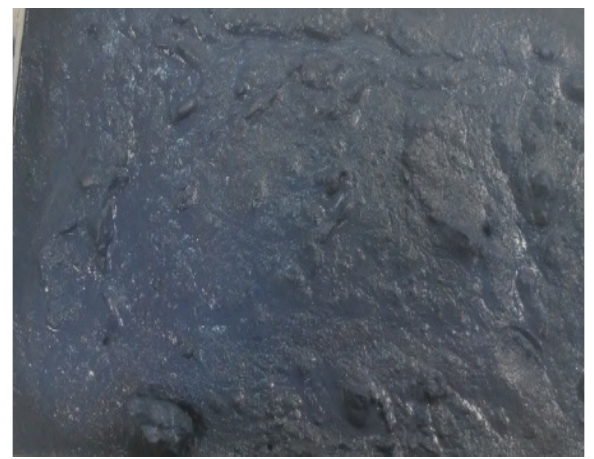
Fig.1 Contaminated Soil by MB